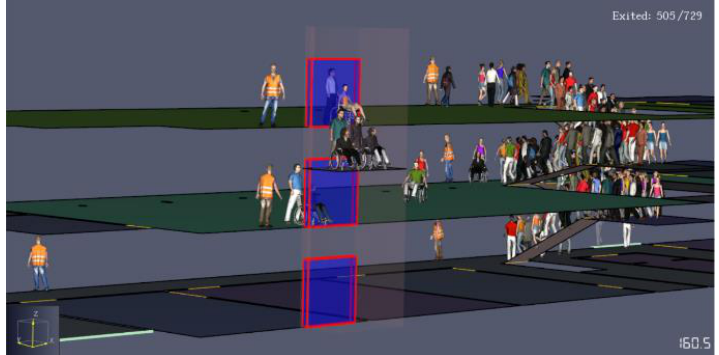
Figure 7. Evacuation situation diagram of barrier-free elevator.